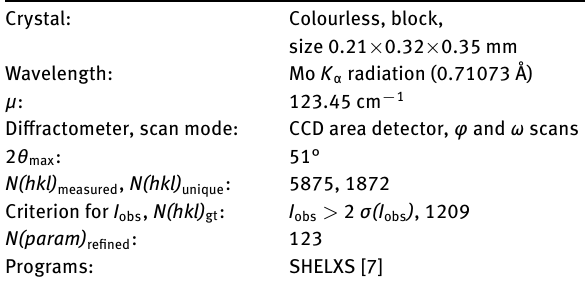
Table 2: Fractional atomic coordinates and isotropic or equivalent isotropic displacement parameters (Å 2